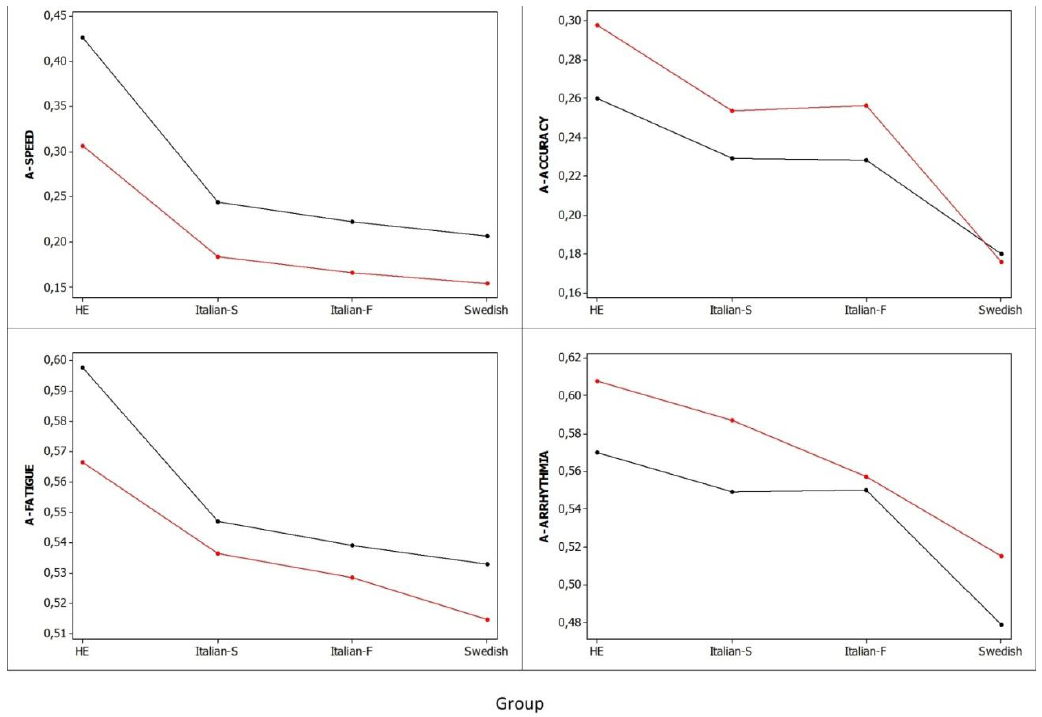
Figure 6. Mean scores of the four automated dimensions for each group, corrected for individual subject variation using mixed-effects models (black line: right hand; red line: left hand). Y-axis: a high score means good function. Group: healthy elderly, HE (n = 286); Italian S (n = 806); Italian F (n = 784); Swedish (n =